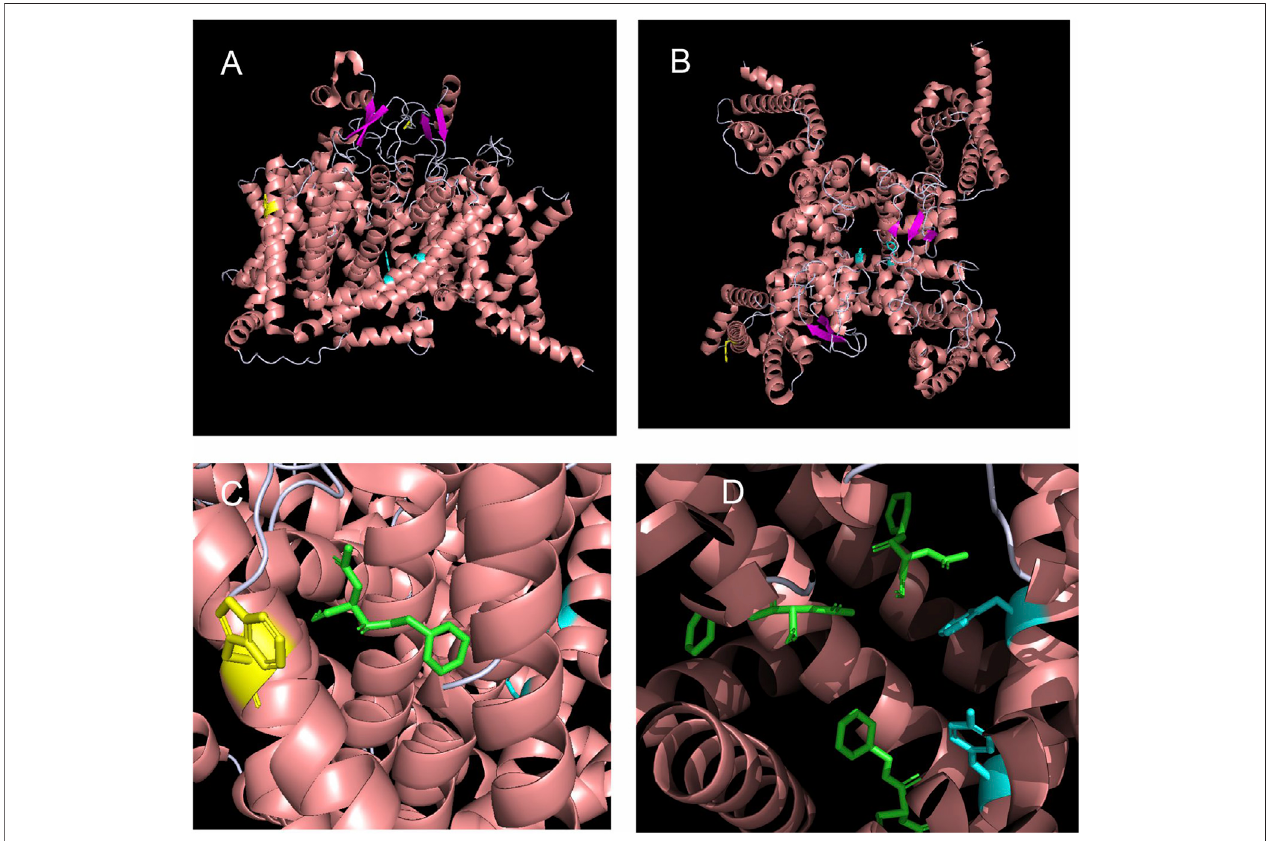
FIGURE 1 | Structural modeling and unbiased docking simulations suggest binding sites of lacosamide on Na V 1.7 channels. (A,B) Structural analysis of sodium channelsallowsthevisualizationoftheW1538residueintheVSDofDIV,asshowninyellow.Thelocalanesthetic(LA)siteF1737andY1744residueslocateintheporeof the channel and are both shown in cyan. Structure of the Na V 1.7 voltage-gated sodium channel is based on Shen et al. (2019) and is represented (A) from the side and (B) fromthetop. (C,D) Insilico dockingidenti fi estheLAsite(F1737/Y1744)andtheW1538asputativebindingsitesoflacosamideonNa V 1.7sodiumchannels. (C) Lacosamide (green) docked in its most favorable position is predicted by blind docking. The W1538 side chain is shown in yellow. (D) Lacosamide (green) docked in its second, fourth, and eighth most favorable positions, predicted by blind docking, near the LA binding site.